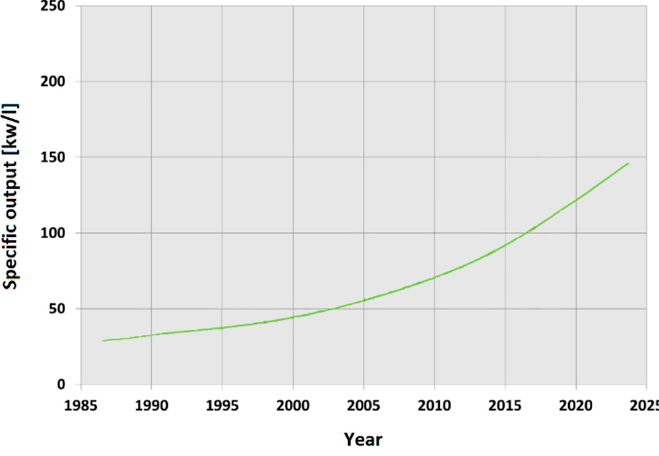
Figure 1. Increasing the specific output of engines [5] .